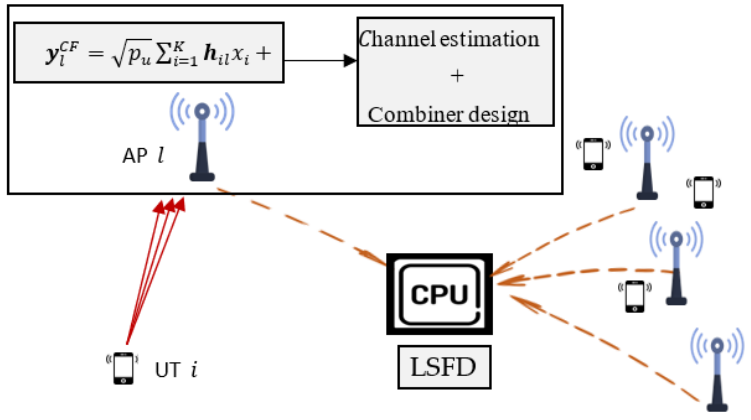
Figure 2. Local Distributed Operations considered in this work .